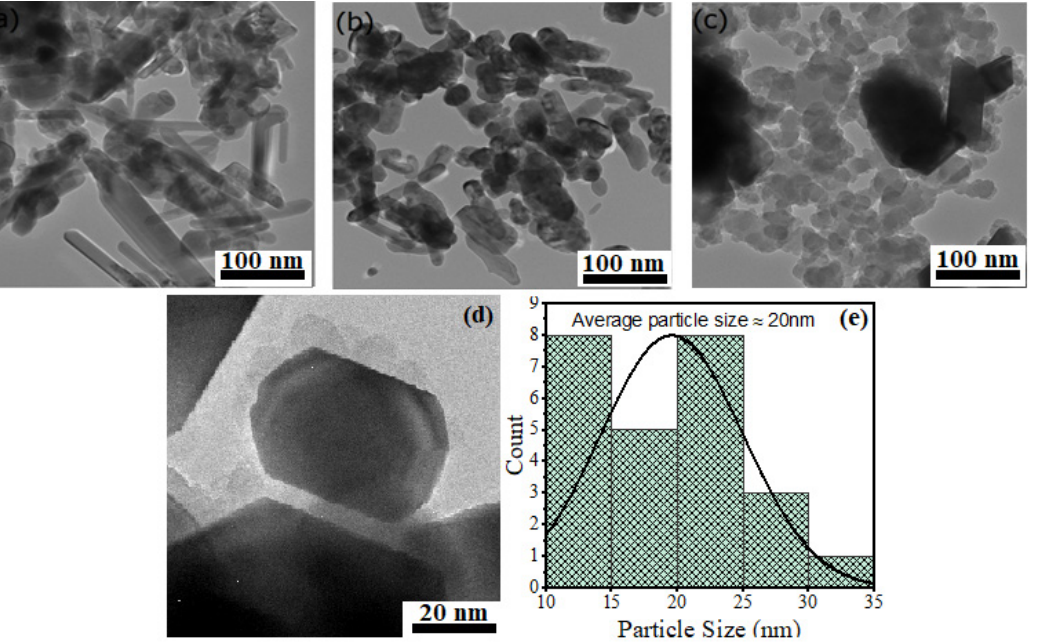
Figure 4. TEM images of the metal tungstates. ( a ) NiWO 4; ( b ) CoWO 4; ( c ) NiWO 4 /CoWO 4 NC; ( d ) particle size distribution of NiWO 4 /CoWO 4 NC; ( e ) statistical gaussian distribution profile for average particle size